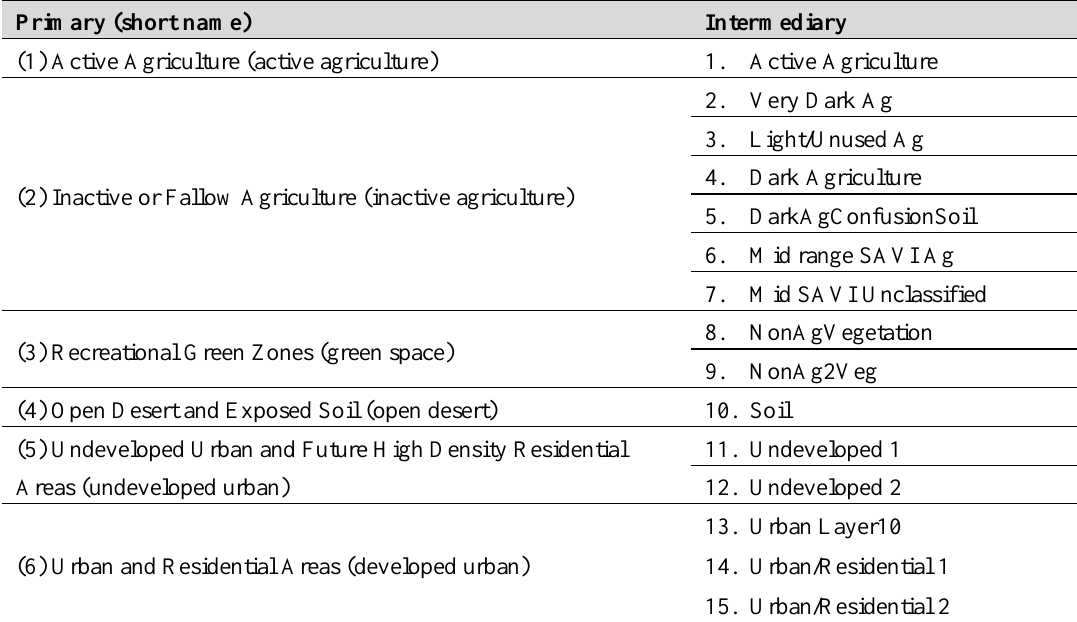
Table 1. Primary and intermediary land-use